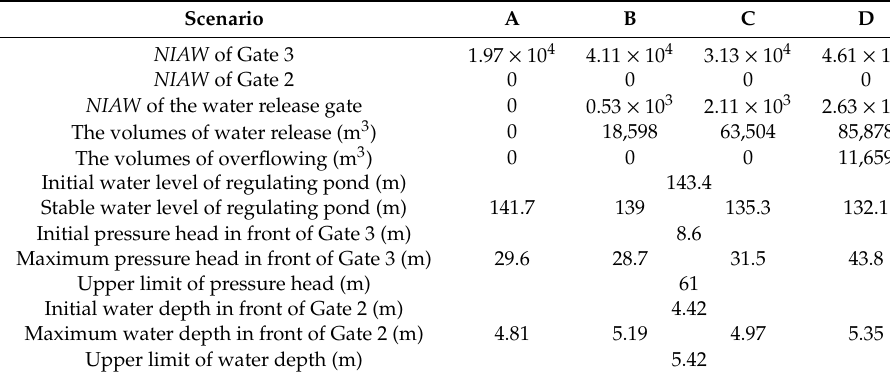
Table 6. Simulation results of test scenarios.